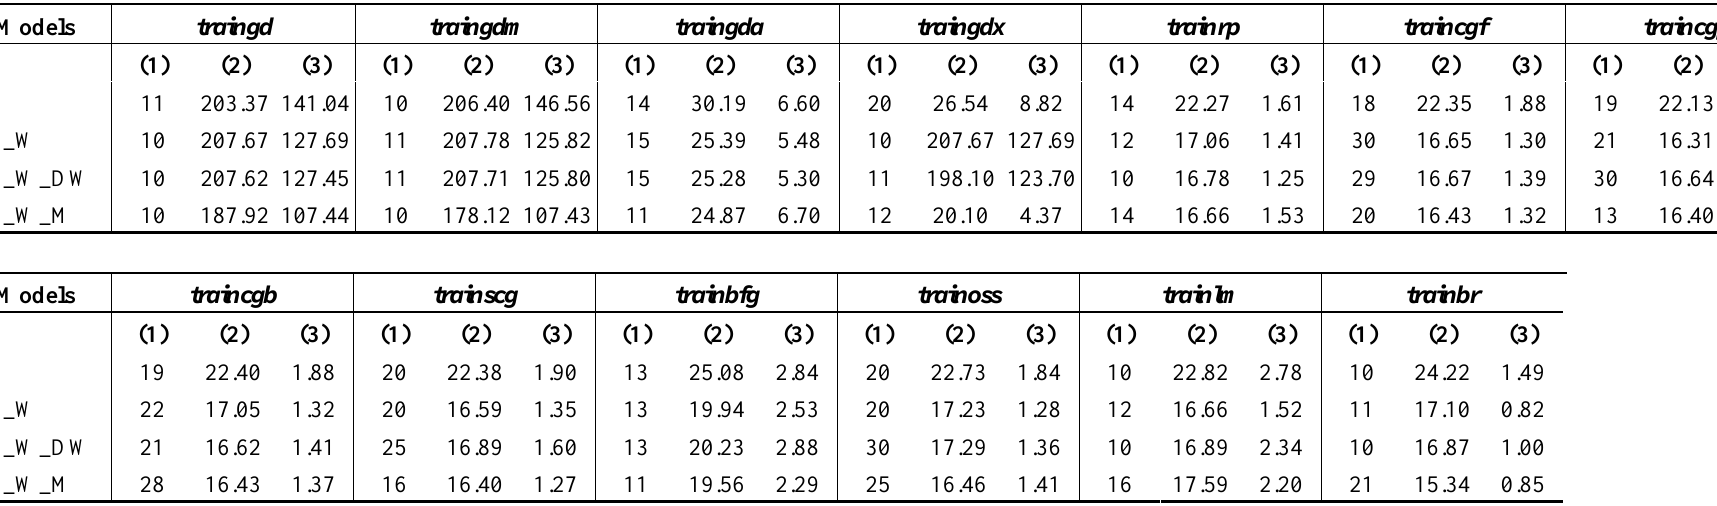
Table 1. Comparison of the minimum MAPE (5) for all the forecast models proposed (Experiment with Data Set A) and for all learning functions. Where: (1) optimal number of neurons for the specific model and learning functions; (2) MAPE (%) for the optimal number of neurons; and (3) standard deviation (%) for the optimal number of neurons.